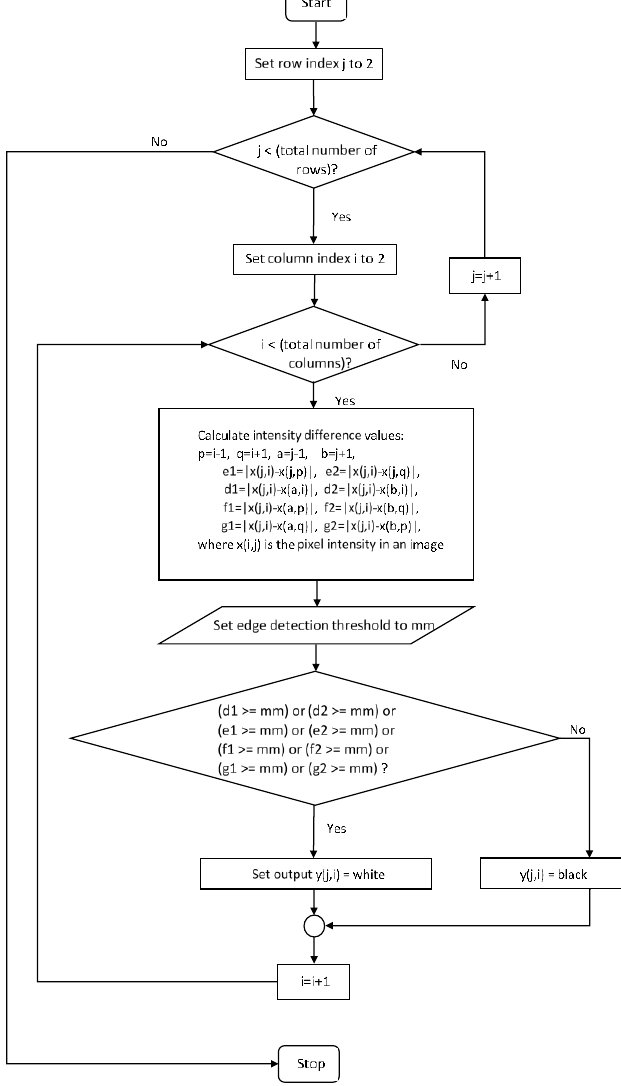
Figure 4. Flow chart of our proposed edge detection procedure.